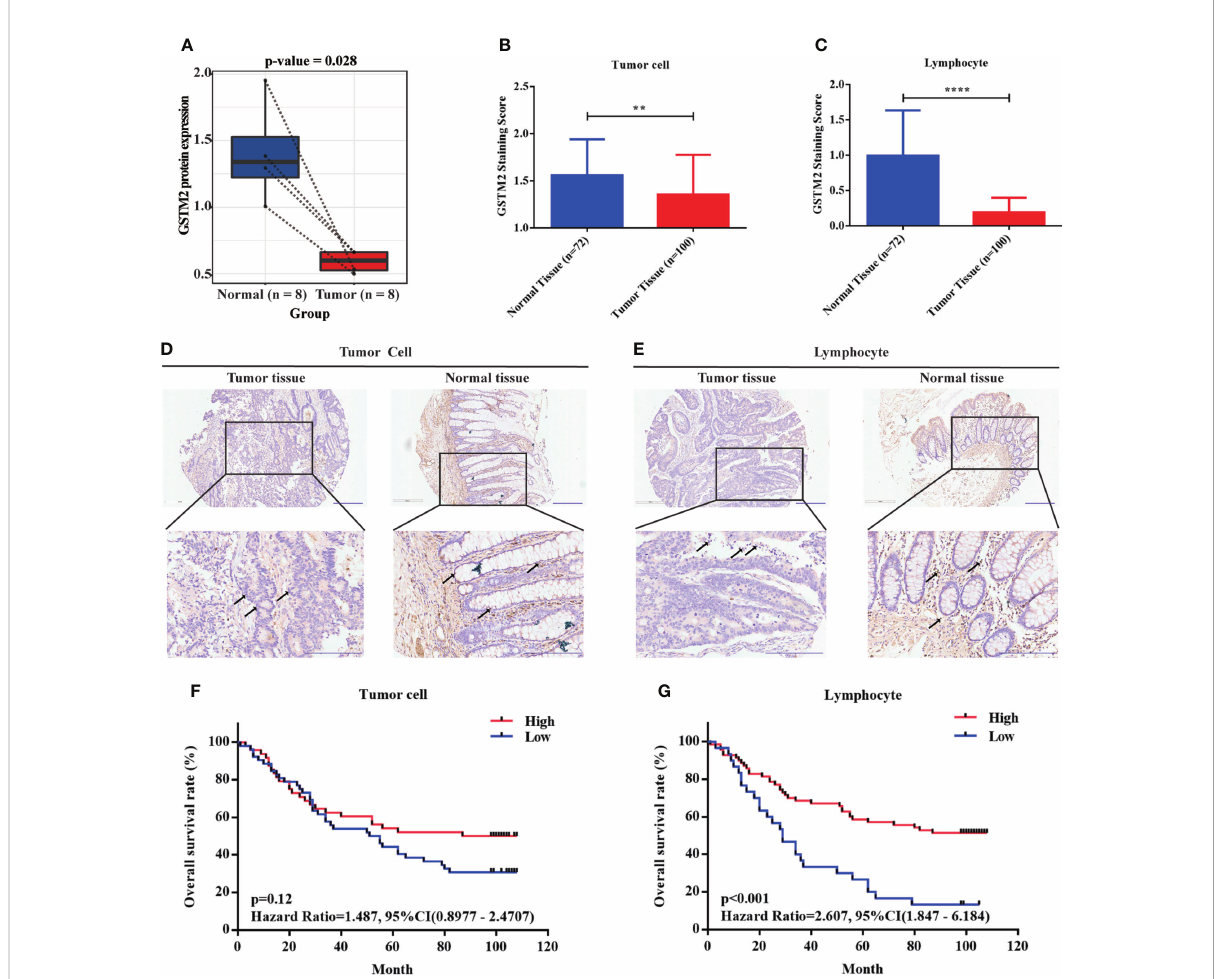
FIGURE 7 The Immunohistochemical Results Disclosed that GSTM2 was Decreasingly Expressed in Tumor Tissues versus Normal tissues Based on our Self-built Chinese Cohort. (A) The GSTM2 expression was evaluated in 4 paired colon cancer tissues and adjacent normal tissues using our own proteomic data. (B) The GSTM2 staining score in colon cancer versus normal tissue. (C) The GSTM2 staining score in lymphocyte within colon cancer tissue versus normal tissue. (D, E) Representative images of immunohistochemical staining of tumor cell and lymphocyte within tumor tissues and normal tissues. The arrows identify representative lymphocytes or tumor cells. (F, G) The correlation between the GSTM2 protein expression with the OS of colon cancer patients based on our self-built Chinese cohort. **p < 0.01 and **** p <